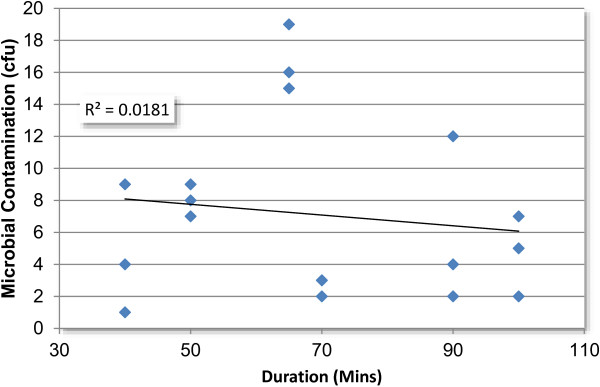
Bacterial air contamination and duration of session.